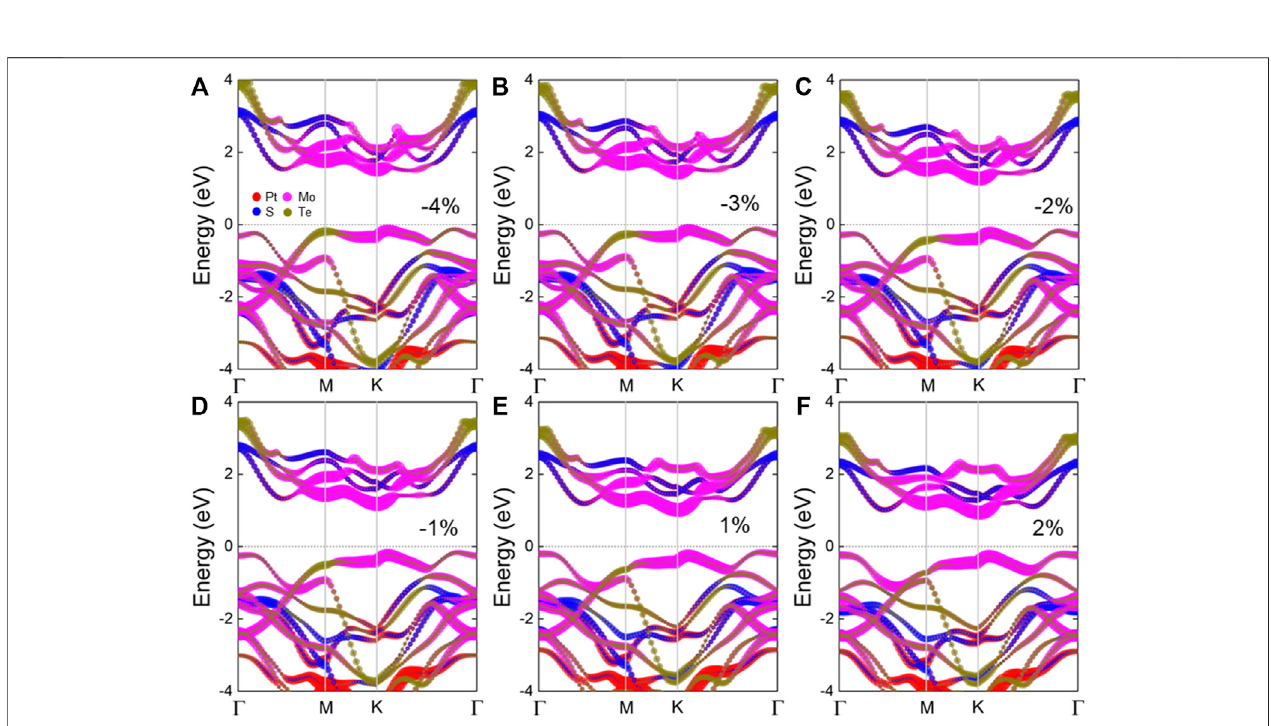
Frontiers in Chemistry |